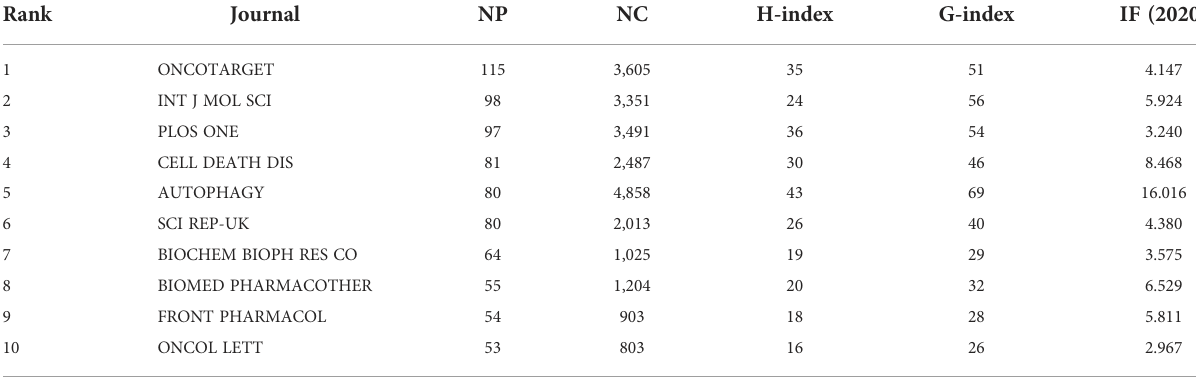
TABLE 4 Top 10 journals for co-citation of autophagy research in lung disease. Rank